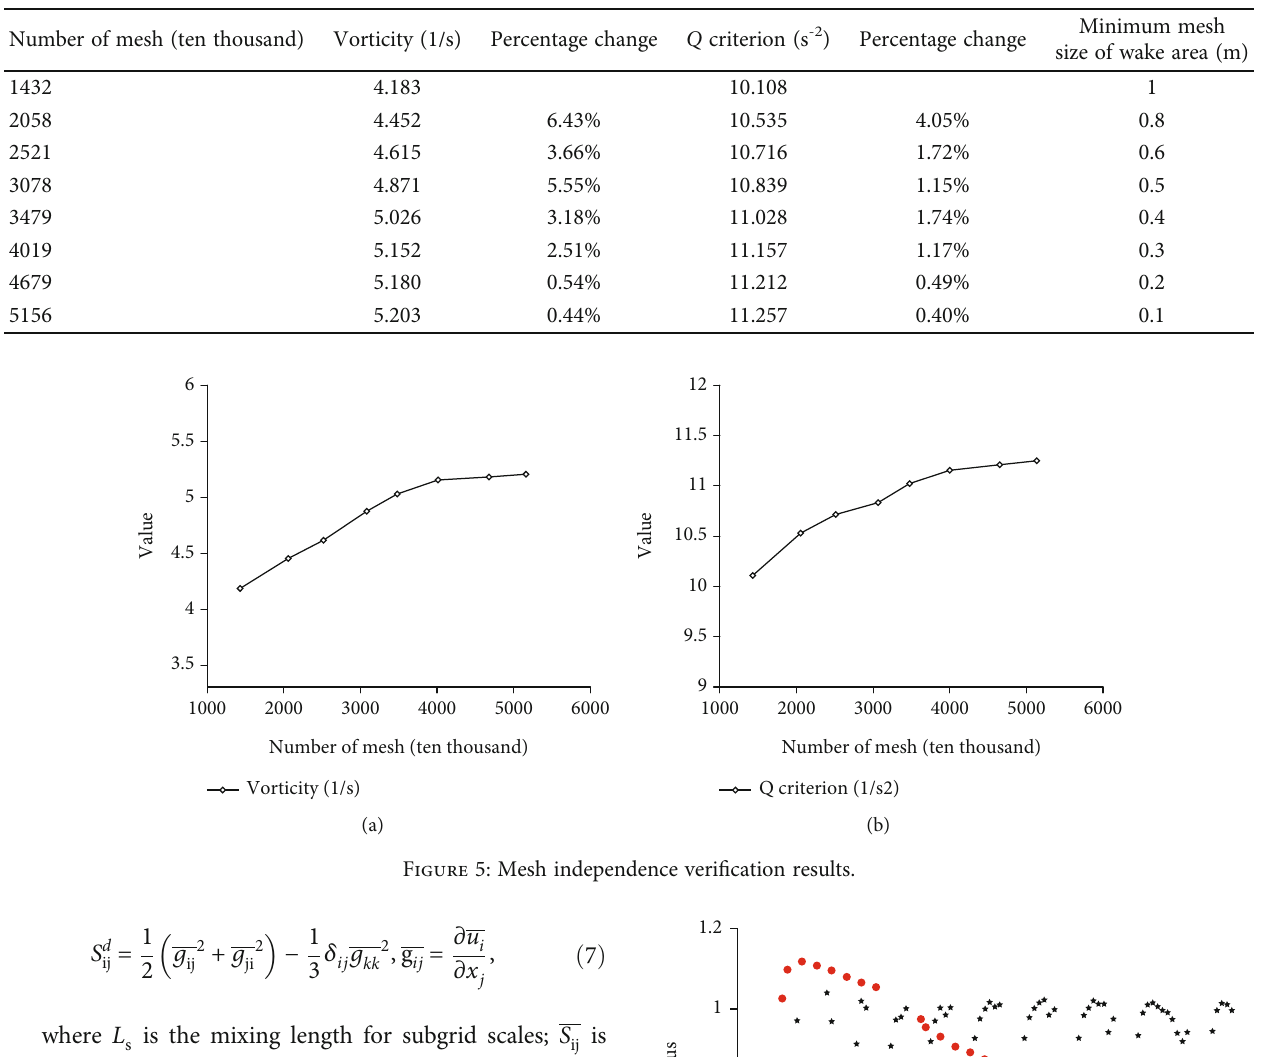
Table 2: Calculation results of di ff erent mesh numbers.